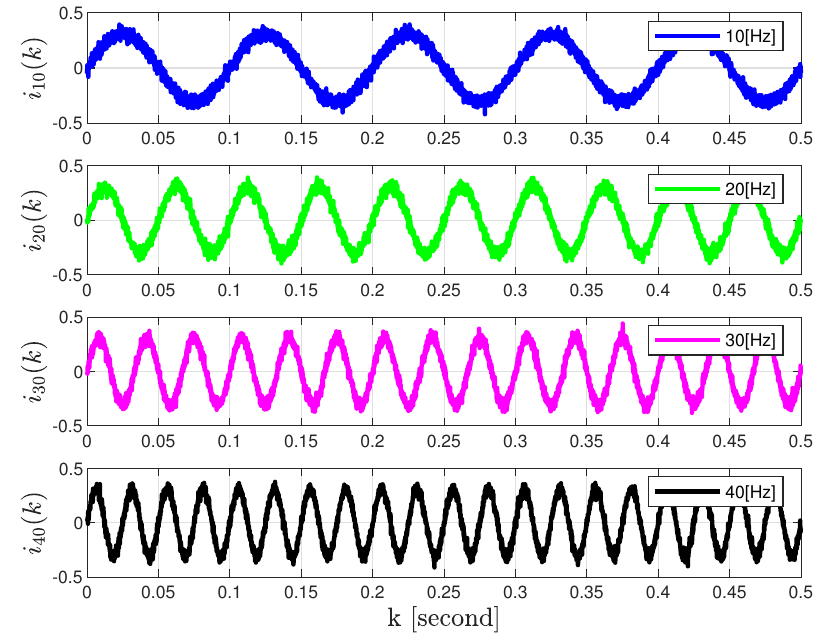
Figure 7. Sinusoidal current signal